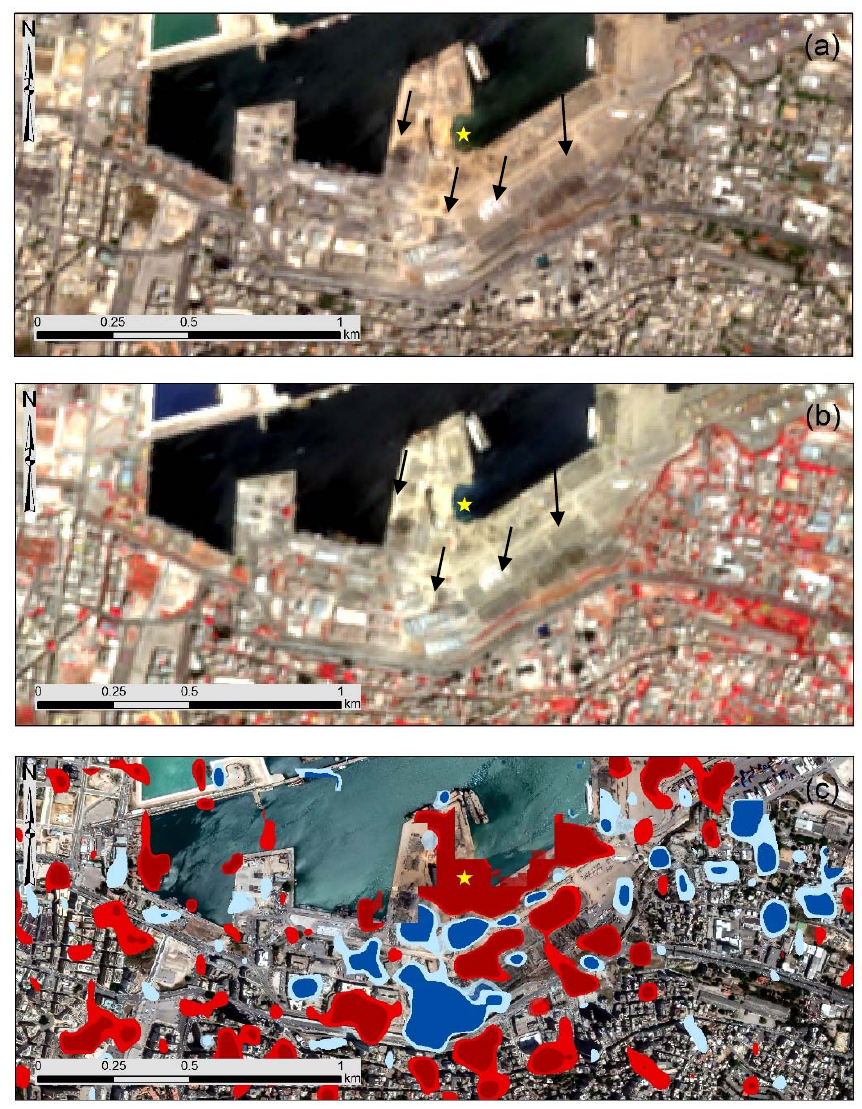
Figure 9. ( a ) Sentinel ‐ 2 optical image taken over the area of interest on the 8th of August 2020 (RGB composite). ( b ) The NIR ‐ R ‐ G pseudo color composite of the same image and ( c ) the change detection results from the Sentinel ‐ 1 image analysis. Black arrows indicate destroyed areas from image interpretation of the Sentinel ‐ 2 image, while yellow arrows indicate the non ‐ detectable destroyed areas from this analysis. The location of the blast size is shown with the yellow star.